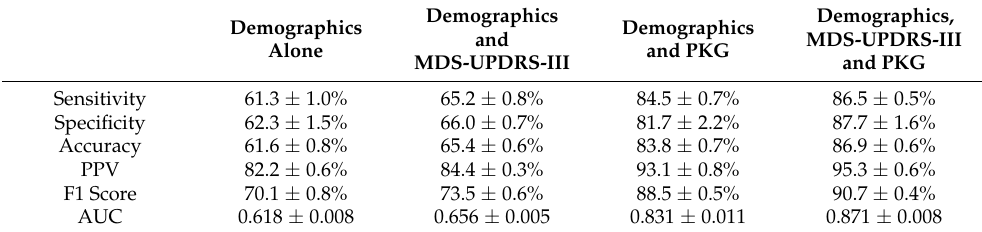
Table 4. Random forest classifier performance identifying subjects in clusters A and B, as stratified through k-means clustering under the best PKG score. Each classifier was trained with a combination of features: Demographic information, demographic information and MDS-UPDRS-III scores (Visit 1), demographic information and PKG time-series data (Visit 1), and demographic information, visit MDS-UPDRS-III scores (Visit 1), and PKG time-series data (Visit 1). Demographics Demographics and Alone